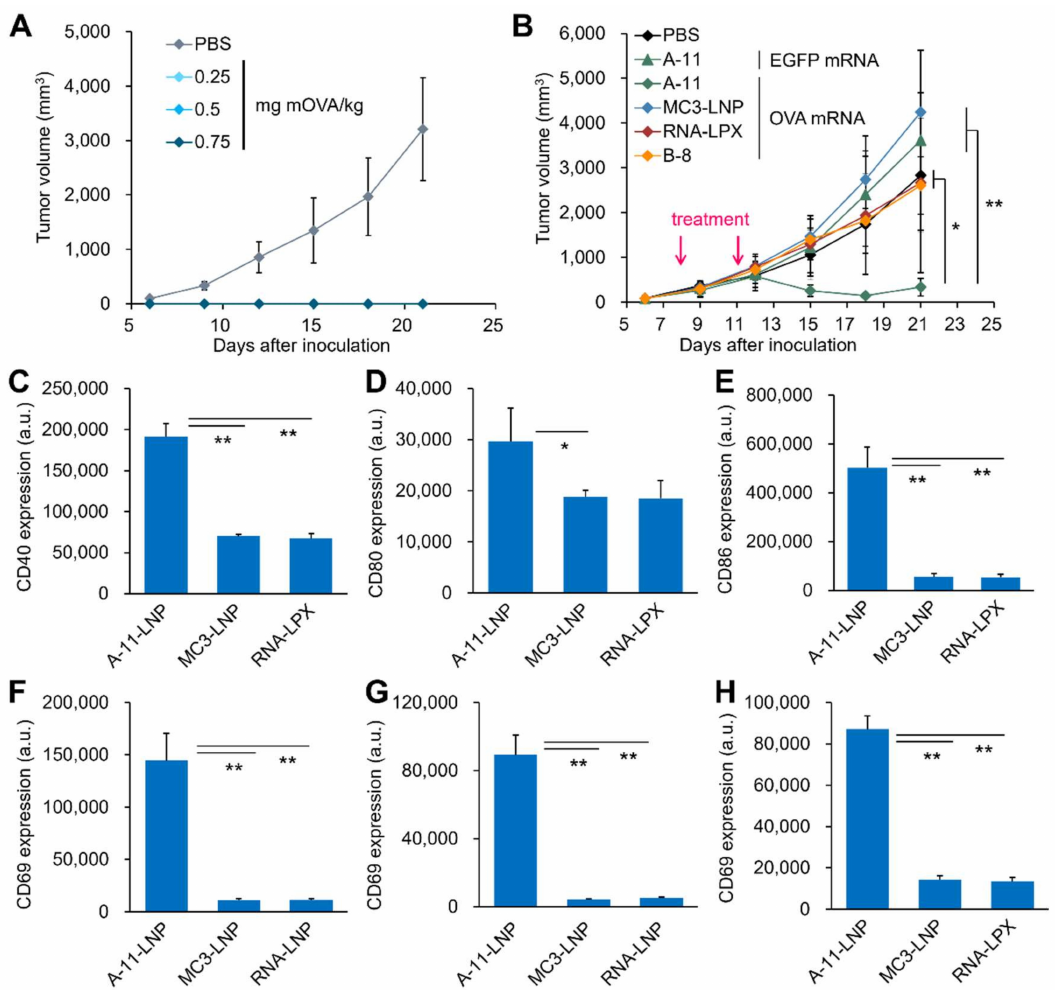
Figure 5. Prophylactic and therapeutic antitumor activity. ( A ) Prophylactic antitumor activity of the A- 11-LNPs in E.G7-OVA tumor-bearing mice. The OVA mRNA-loaded A-11-LNPs were intravenously injected at the indicated doses twice on 14 and 7 days before tumor inoculation. n = 3–4. ( B ) The therapeutic antitumor activity of the A-11-LNPs, MC3-LNP, RNA-LPX, and B-8-LNPs. E.G7-OVA tumor-bearing mice were intravenously injected with OVA mRNA-loaded formulations at two doses of 0.03 mg mRNA/kg on day 8 and 11. n = 5. * p < 0.05, ** p < 0.01. ( C – E ) Expression of activation markers CD40 ( C ), CD80 ( D ), and CD86 ( E ) in splenic DCs 24 h after an intravenous injection of OVA mRNA-loaded formulations at a dose of 0.03 mg mRNA/kg. n = 3. * p < 0.05, ** p < 0.01. ( F – H ) Expression of an activation marker CD69 in splenic B cells ( F ), T cells ( G ), and NK cells ( H ) 24 h after an intravenous injection of OVA mRNA-loaded formulations at a dose of 0.03 mg mRNA/kg. n = 3. ** p <